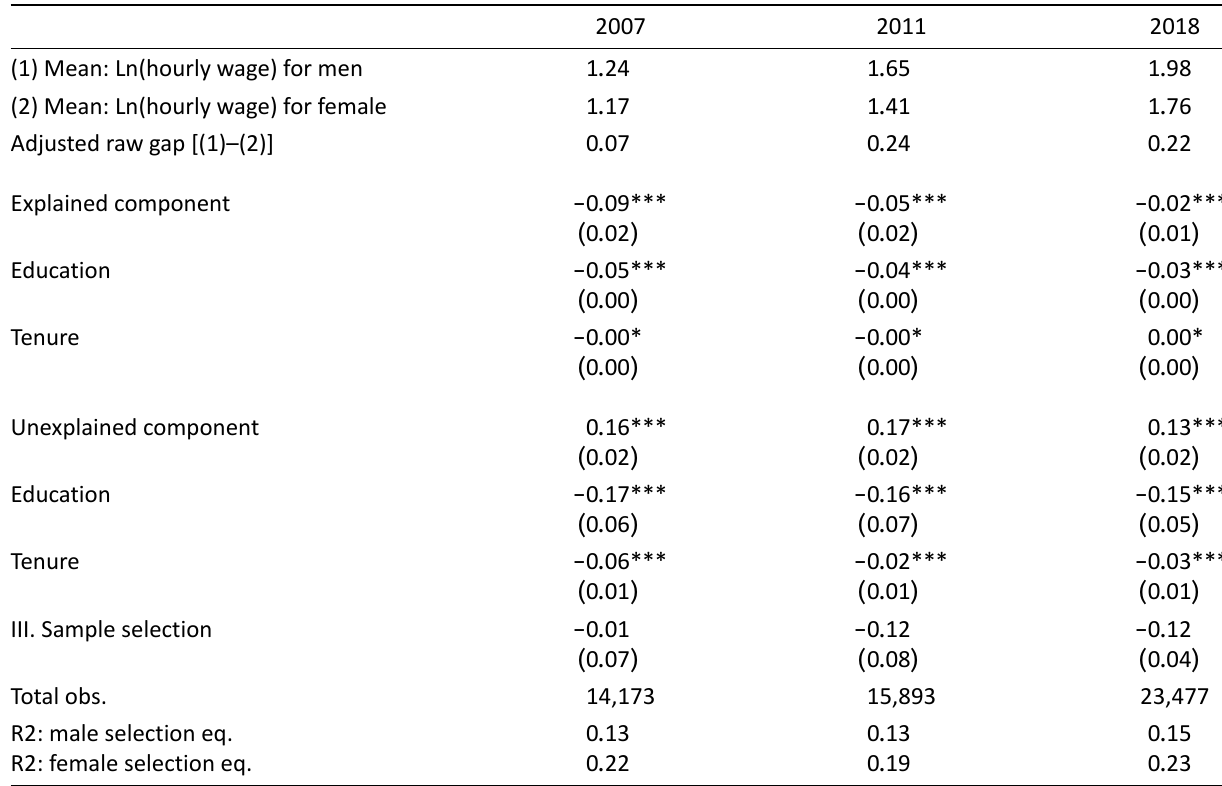
Table 4. Heckman‐adjusted Oaxaca‐Blinder decomposition.